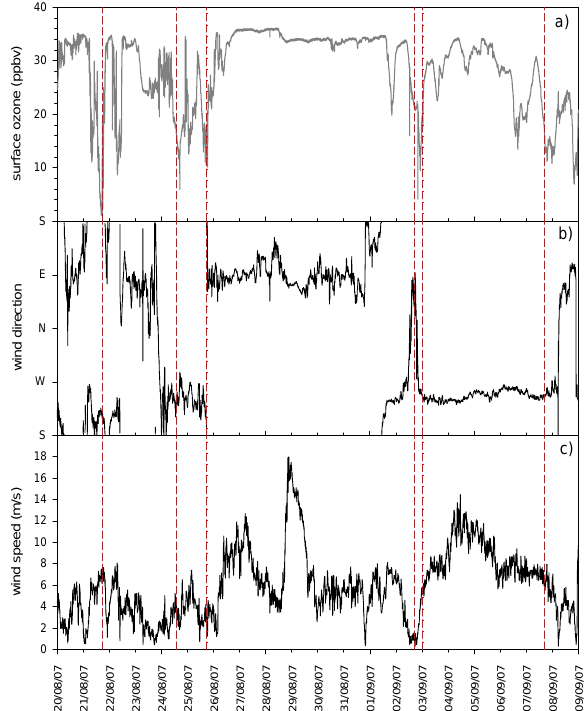
Fig. 2. Timeseries of (a) surface ozone, (b) wind direction, and (c) wind speed measured during the period of the tethersonde profiling experiments. The red lines indicate the mid-point of the tethersonde profiling